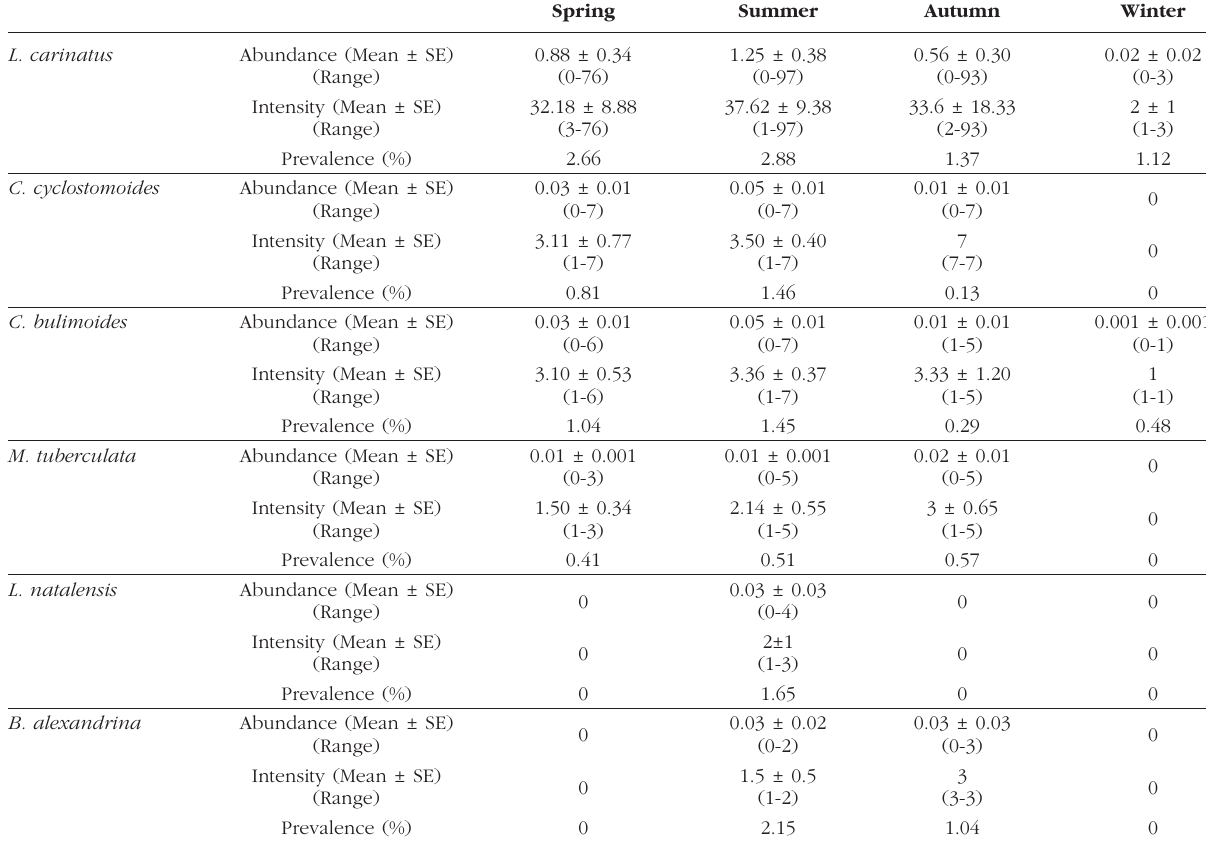
Table III. – Seasonal prevalence, mean abundance and intensity of P. cantonensis infection among different freshwater snails in Al-Abtal village (a new cultivated area in north